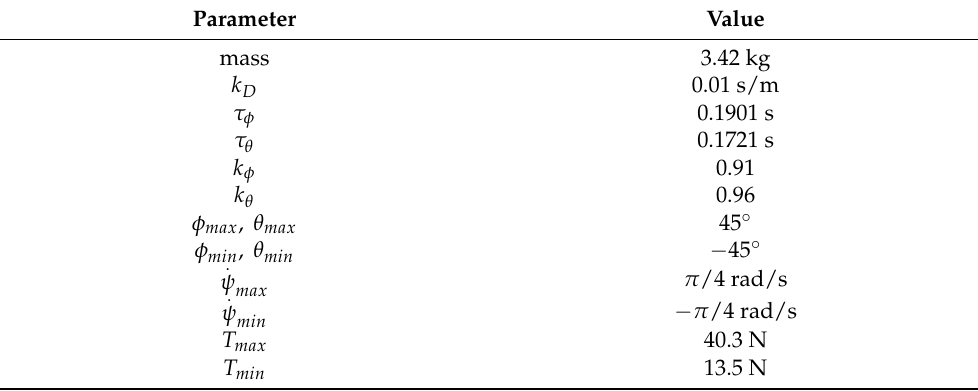
Table 1. NEO hexacopter parameters and control input constraints.